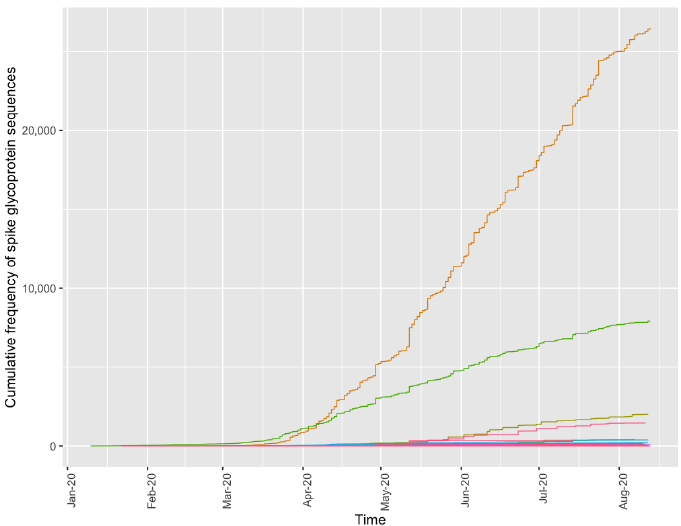
Figure 6. Spike glycoprotein variantsobserved in SARS-CoV-2 genomes over time and geography. Each line represents the cumulative frequency per variant (orange: D614G, green: UniProt ID P0DTC2, olive: P1140X, pink: S2 cleavage product). Low frequency S protein sequences (<5 observations) are removed from plotting for